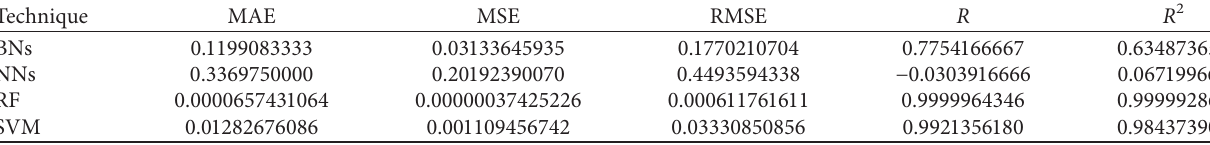
Table 2: Metrics used to measure the accuracy of experiments for dose calculation. Technique